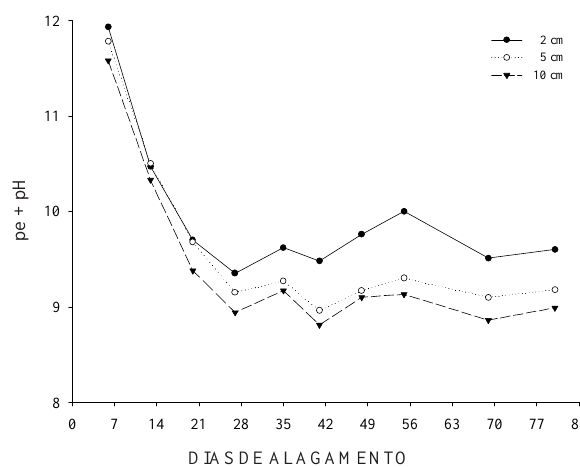
Figura 2. Valores de pe + pH da solução do solo em três profundidades de um Planossolo submetido a alagamento.